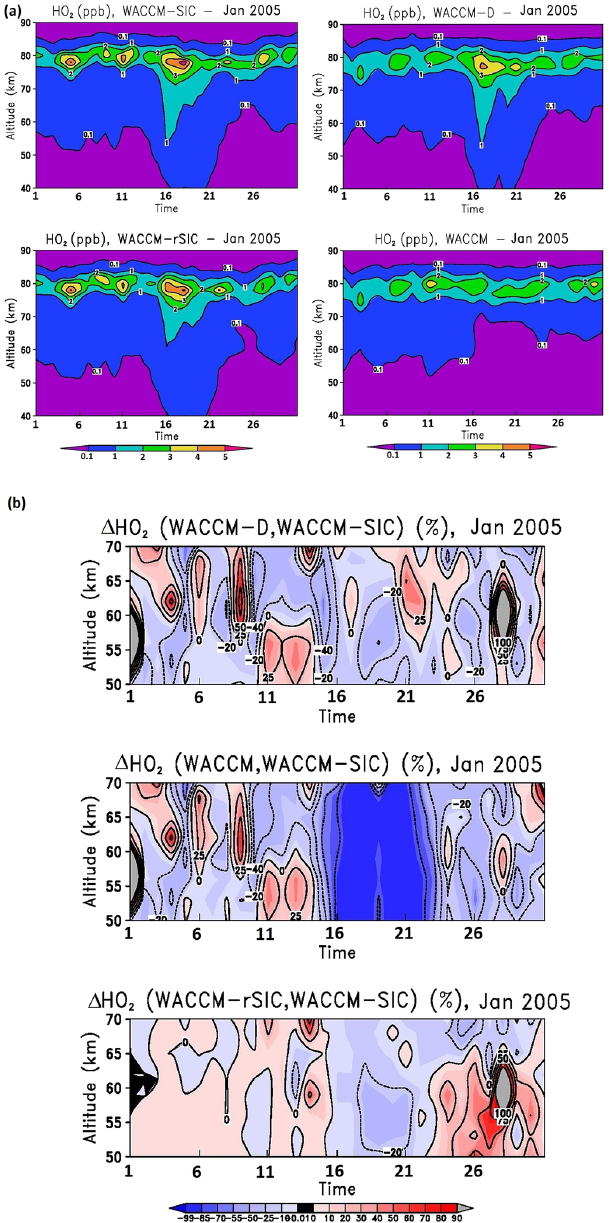
Figure 7. (a) Zonal mean vertical concentration profiles of mesospheric/upper-stratospheric HO 2 (in ppb) for Northern Hemi- sphere polar latitudes (60–90 ◦ N) during January 2005; (b) percent- age difference between three models (WACCM-D, WACCM and WACCM-rSIC) and the full WACCM-SIC.